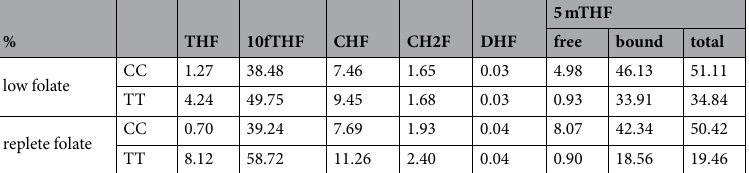
Table 6. Distribution of folate (in percentage of total folate) for replete (18 µ M) and low (9 µ M) levels of total folate and for the CC and TT case of the C667T MTHFR